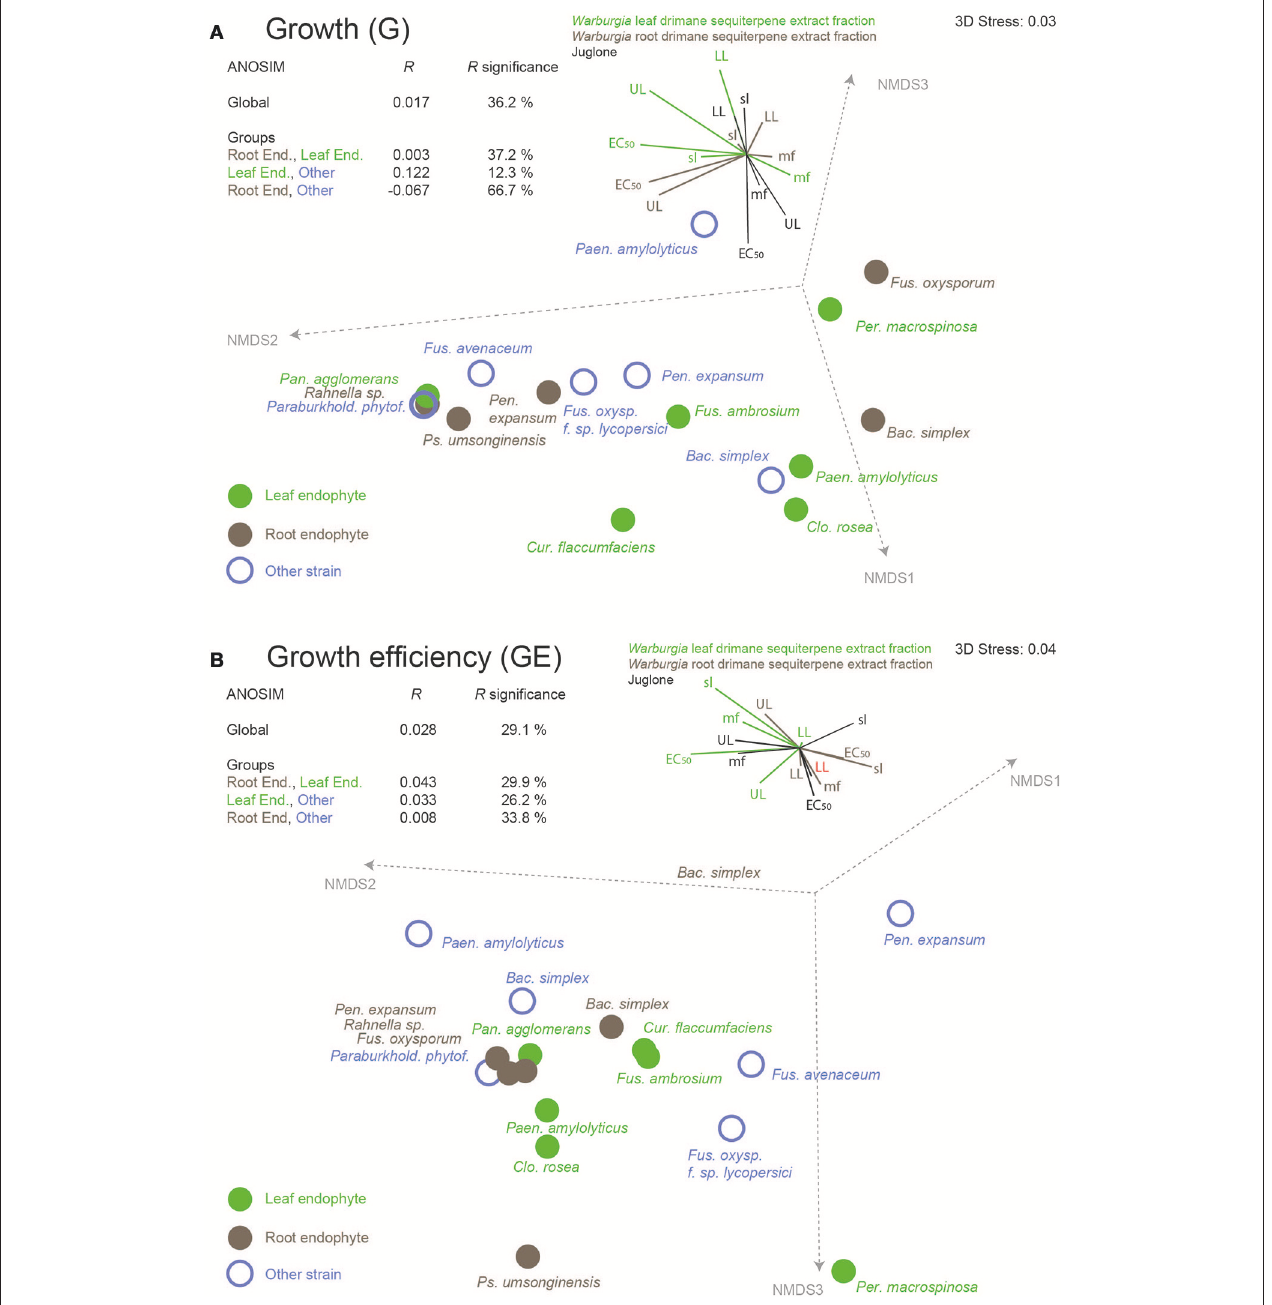
FIGURE 2 | Dissimilarities of leaf and root endophytes of the African pepper bark tree, Warburgia ugandensis , and randomly selected other strains on basis of (A) growth susceptibility and (B) growth efficiency against the leaf and root drimane sesquiterpene fraction and the naphthoquinone juglone, a highly redox-active plant metabolite. Variable contributions of EC 50 , lower level (LL), upper level (UL), slope (of the sigmoidal dose–response curve) and lack-of-fit p (mf, model fit), all parameters from curve fitting of the original data to a log-logistic growth model, are illustrated as vector plots.